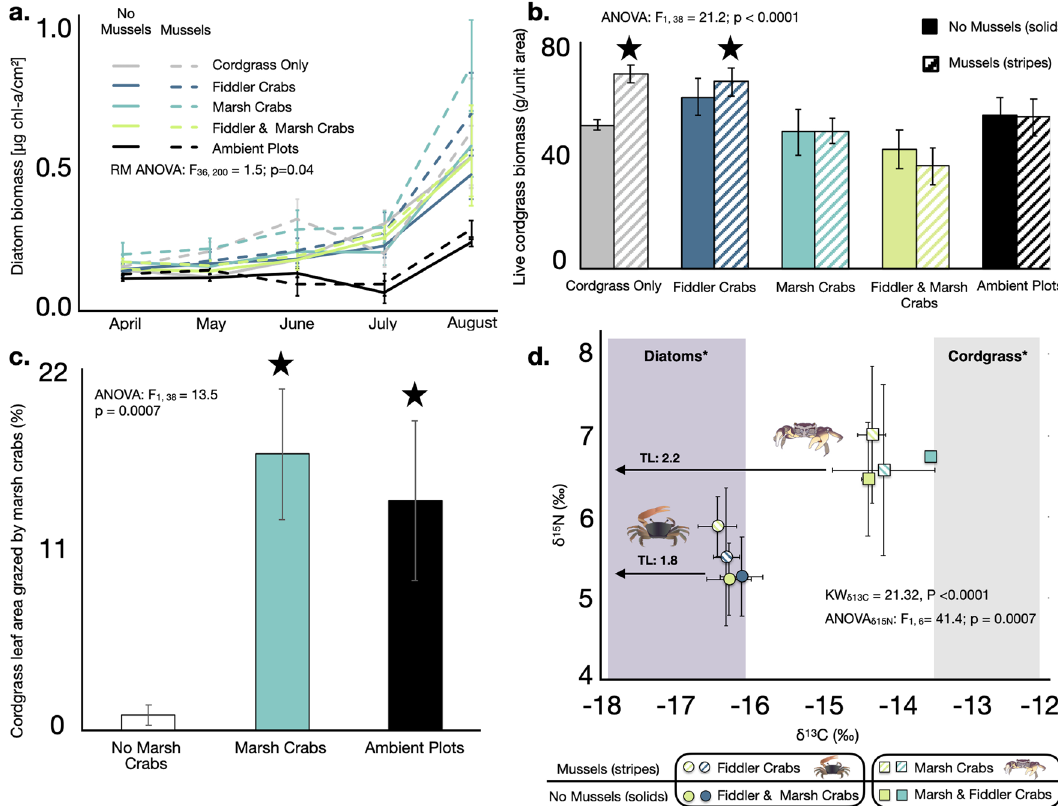
Figure 2. Inverttebrate composition effects on primary producer biomass, grazing damage, and crab diet. Diatom biomass recorded over the 5-month field experiment ( a ), and above ground cordgrass biomass ( b ), percent of cordgrass leaf area grazed by marsh crabs in all enclosures without marsh crabs (white), all enclosures with marsh crabs (teal) and all ambient plots (black) ( c ), and the δ 13 C and δ 15 N isotopes of fiddler and marsh crabs ( d ) recorded at the end of the experiment. Data are shown as the mean ± standard error of 3–4 measurements per plot per date in a ; 6 replicate plots in ( b) ; 23 replicate enclosures without marsh crabs, 12 replicate enclosures with marsh crabs, and 12 replicate ambient plots exposed to background levels of marsh crabs in ( c) ; and 3 replicate enclosures per crab per treatment in ( d ). In ( d ), grey and purple shading denote the δ 13 C range previously reported for cordgrass and benthic algae, respectively, along the Georgia coast 30 . Colors and patterns denote treatment as defined in the legends for panels ( a , b , d ). Statistically significant findings (black star) are identified in ( b , c ). Summaries of statistical tests are shown as insets to each panel. Invertebrate icons were obtained through the Integration and Application Network or Google Imaged (labeled for reuse with